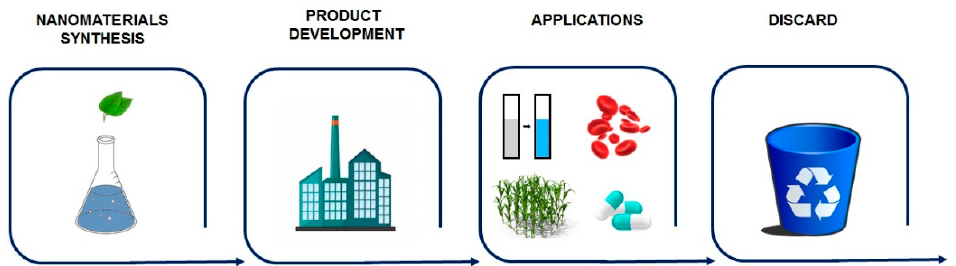
Figure 1. The life cycle of NMs. It begins with extensive research and development of an appropriate synthesis route, followed by the development of a product and its consequent use. Finally, it is necessary to correctly dispose of the NM products when no longer utilized.